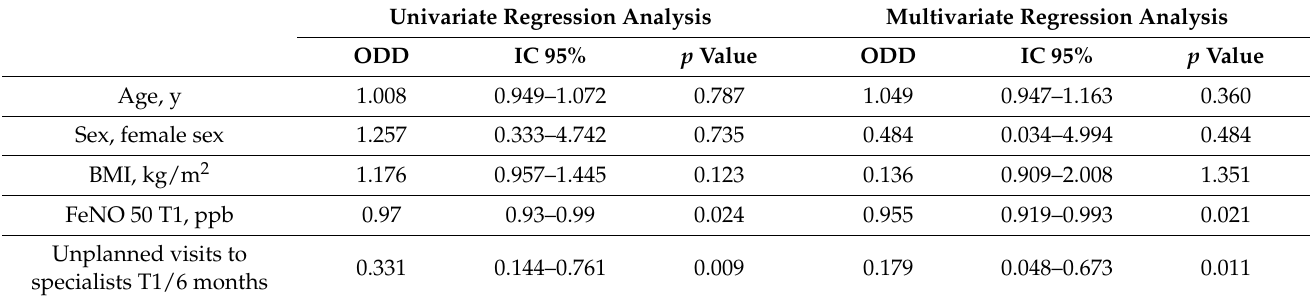
Table 6. Prediction of LTRA